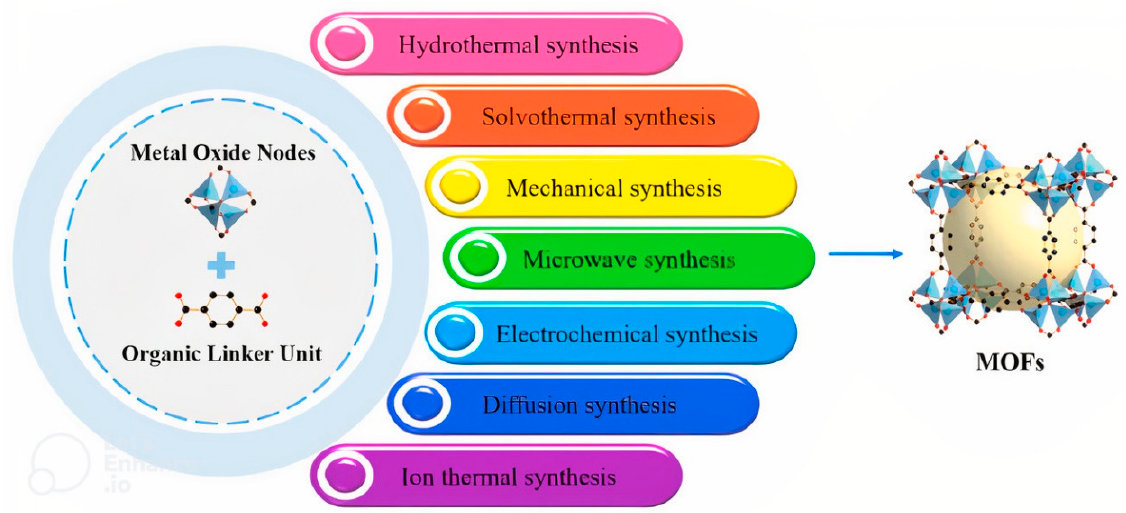
Figure 1. Synthesis pathway for MOFs, reproduced with permission from [75]. Copyright Else- vier,